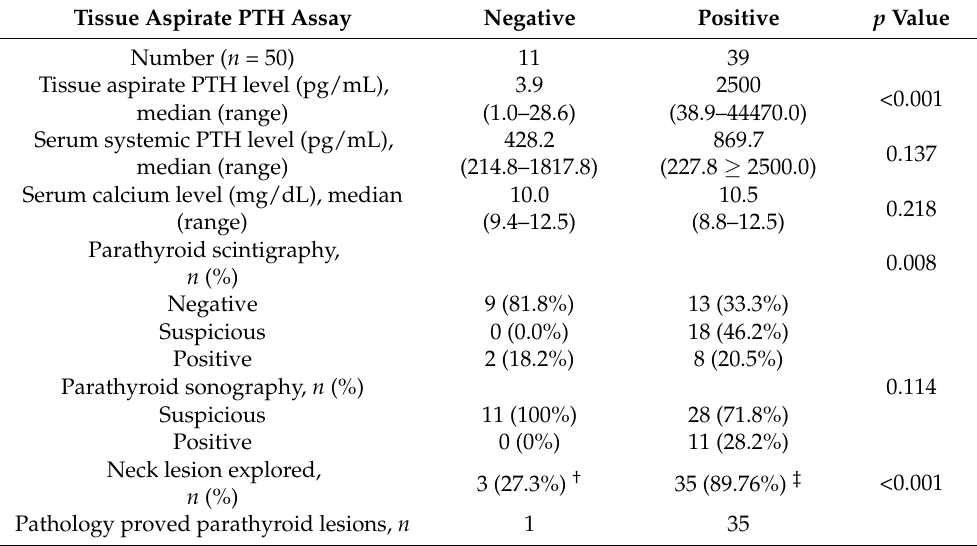
Table 1. Comparison between cohorts with positive and negative tissue aspirate PTH